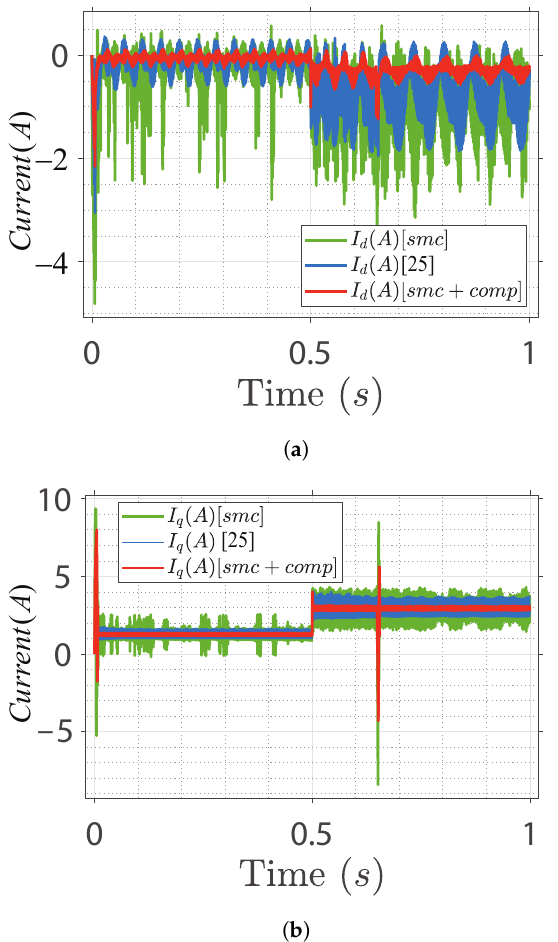
Figure 8. Reference output state’s variable. ( a ) D-axis current. ( b ) Q-axis